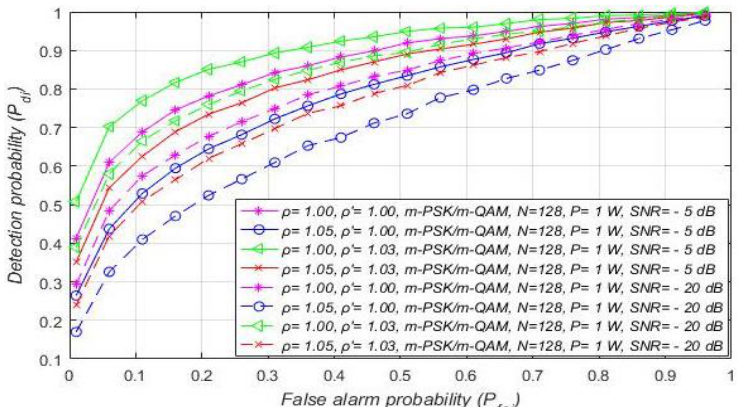
Figure 6. Interdependence between probabilities of detection and false alarm for ED of signals in RA systems, versatile combinations of NU and DT factors, and two distinct SNR levels.